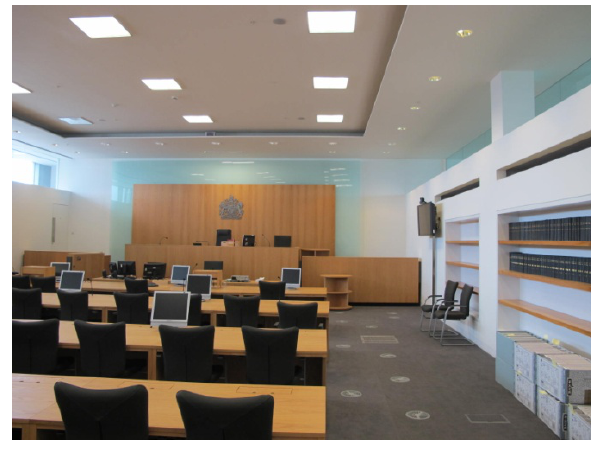
Figure 11. Upper Court Room with air slot at RHS.